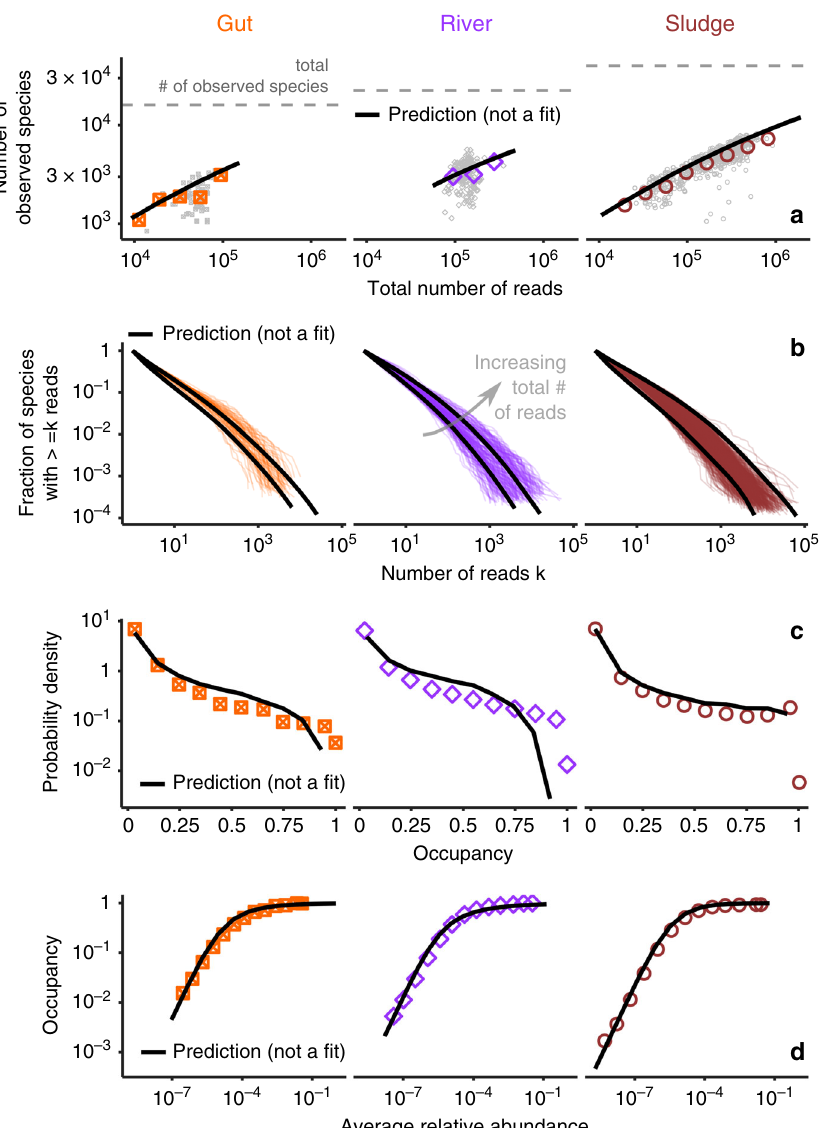
Fig. 3 The AFD, Taylor ’ s Law and MAD quantitatively predict macroecological patterns. a Scaling of diversity (measured as the number of species) with the total number of reads (Supplementary Fig. 13). b Species abundance distribution (Supplementary Fig. 17). c Occupancy distribution (Supplementary Fig. 15). d Abundance-occupancy relation 21 (Supplementary Fig. 16). Data are colored points/line. Predictions (black lines) are obtained from the macroecological laws without fi tting any additional parameter. Gray points in ( a ) are individual communities (colored points are